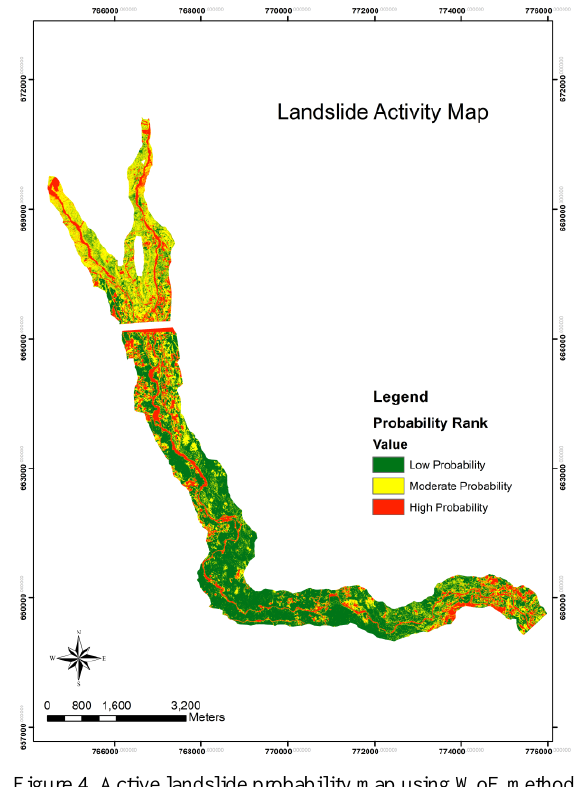
Figure 4. Active landslide probability map using WoE method